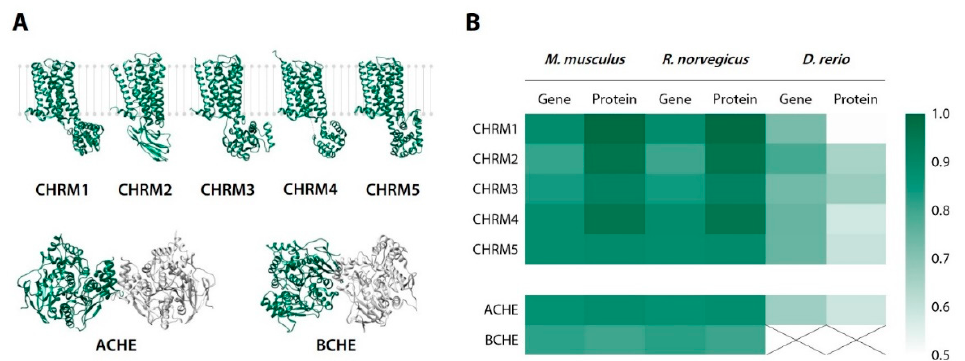
Figure 14. Putative cholinergic targets for chromone-containing allylmorpholines ( A ) and a heatmap of their gene/protein homologue identity to Homo sapiens ( B ). CHRM, muscarinic acetylcholine receptor; AChE, acetylcholinesterase; BChE, butyrylcholinesterase. The sequence analysis of H. sapience vs. D. rerio , however, returned 72.7–79.2%, 74.7%, and 66.4% identities for CHRM 1–5 , AChE, and BChE genes, respectively, and 50.6–67.3%